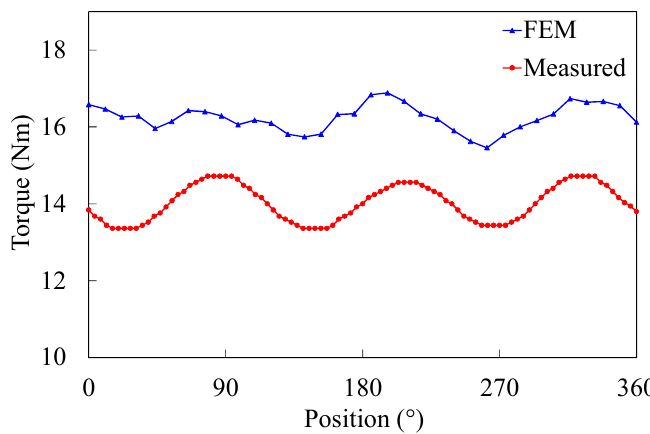
Figure 24. Comparison of the torque results of measured and FEM.